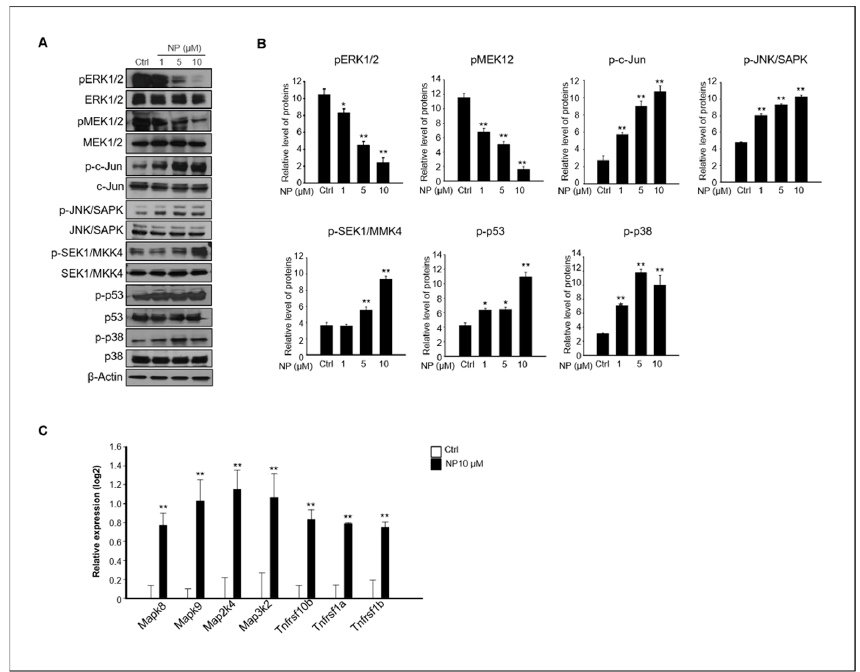
Figure 5. The effects of NP on MAPK activity . ( A ) The protein expression levels of pERK1/2, T-ERK1/2, pMEK1/2, p-c-Jun, p-JNK, p-MMK4, p-p53, p-p38, and β -actin in cells treated with 0, 1, 5, and 10 μ M NP for 24 h. ( B ) The graph represents the densitometric analysis of each band normalized to that of each inactive protein band. ( C ) The gene expression levels of Mapk8, Mapk9, Map2k4, Map3k2, Tnfrsf10b, Tnfrsf1a, and Tnfrsf1b in GC-1 spg cells treated with 10 μ M NP compared with untreated controls. Values represent the mean ± SD of three independent experiments ( n = 3, * p < 0.05 and ** p < 0.01 compared to the controls).